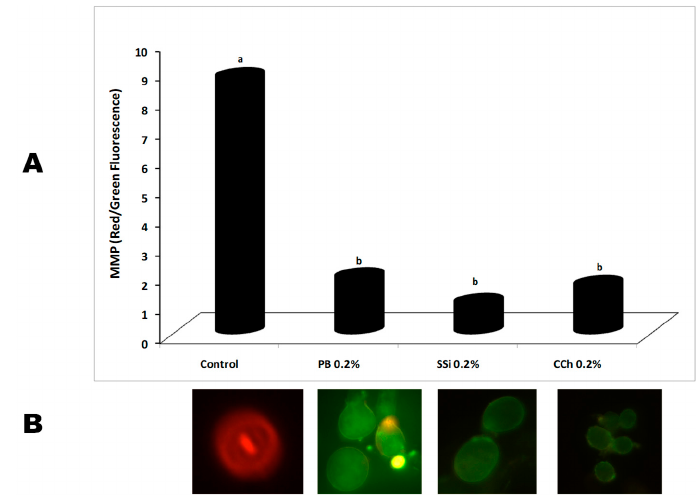
Figure 10. (A) Effect of potassium bicarbonate (PB), sodium silicate (SSi), and calcium chelate (CCh) at 0.2% on mitochondrial membrane potential (MMP) of Botrytis cinerea conidia represented as red/green florescence ratio and detected by MitoProbe™ JC-1 Assay Kit. Values marked with the same letters are not statistically different by Fisher’s protected least significant difference test at p ≤ 0.05. (B) For each treatment representative images of stained conidia under fluorescence microscopy were showed.